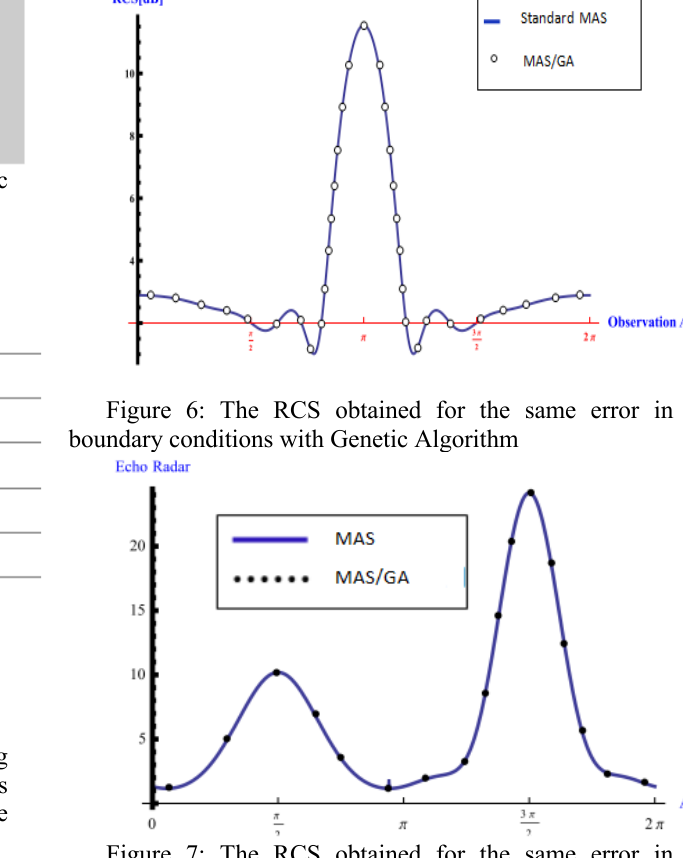
Figure 7: The RCS obtained for the same error in boundary conditions with Genetic Algorithm for square cylinder section=0.7